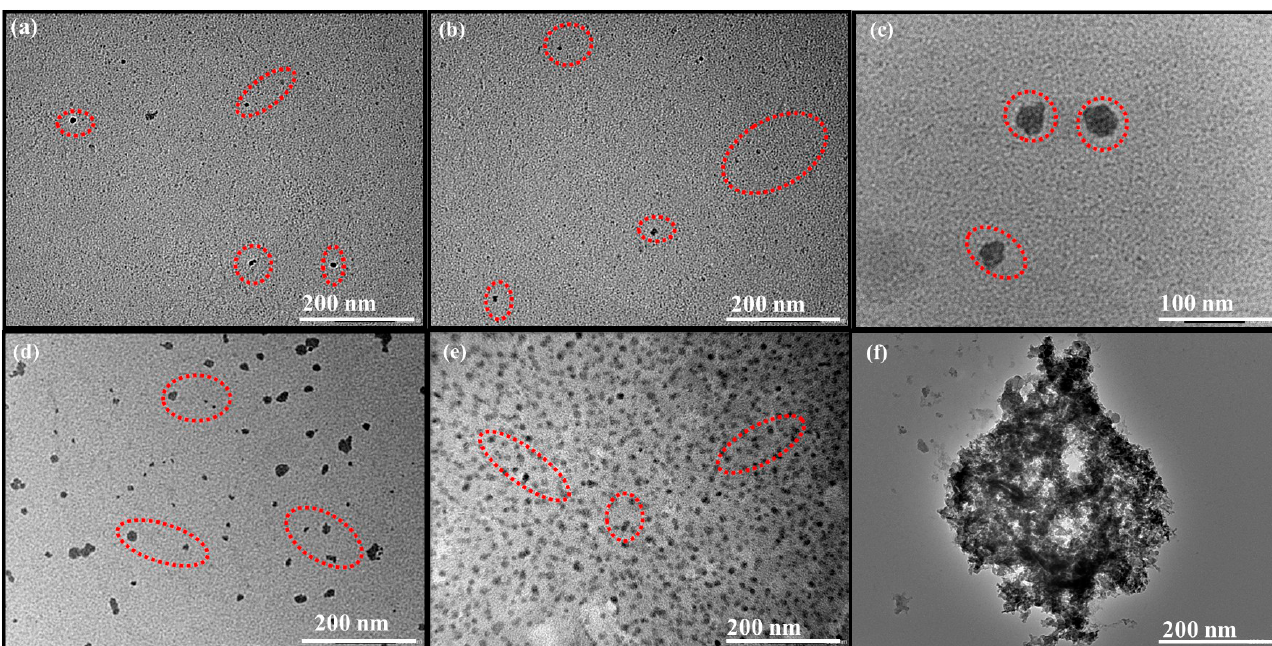
Figure 2. TEM micrographs of ( a – c ) P@CQDs, C@CQDs, B@CQDs and ( d – f ) P@ACs, C@ACs and B@ACs, respectively.